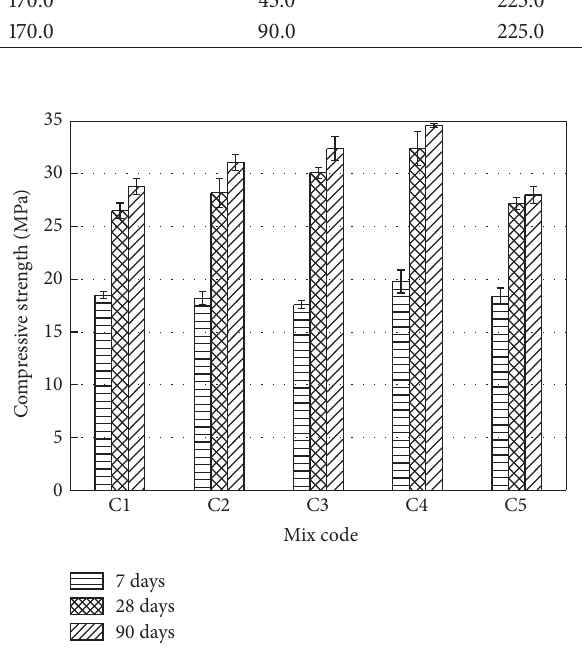
Figure 3: Development of compressive strength of designed